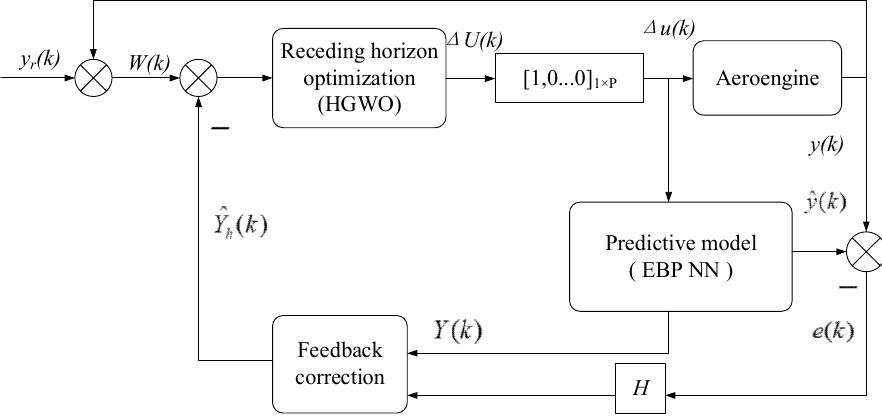
Figure 4. Flow chart of hybrid grey wolf optimization (HGWO).